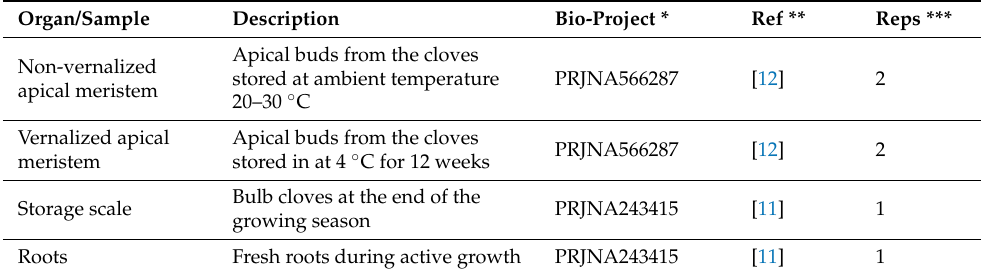
Table 2. List of samples for transcriptome sequencing, collected at different stages of plant develop- ment and after cold-storage treatments. Seed-setting garlic genotype #87 was used in all transcriptome